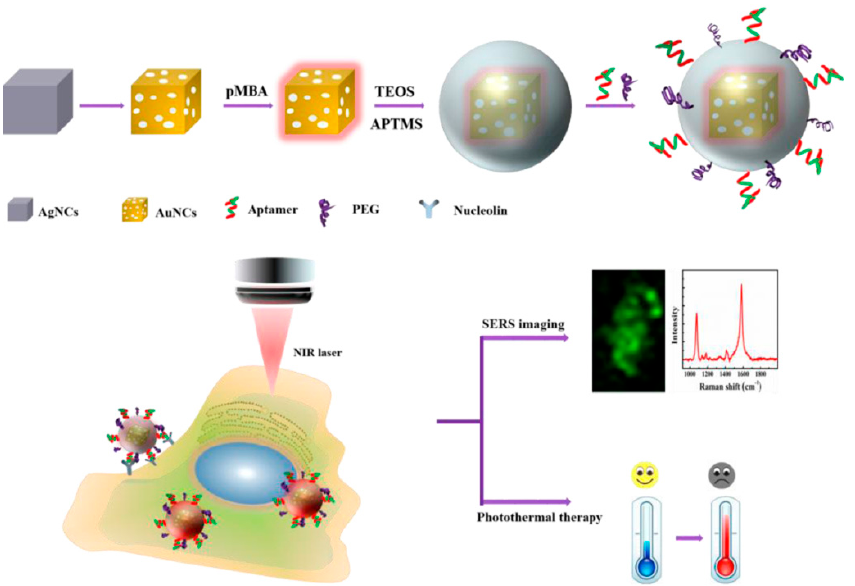
Figure 19. Schematic diagram of cellular SERS imaging and photothermal therapy. (Reprinted with permission from ACS, 2019 [91]).